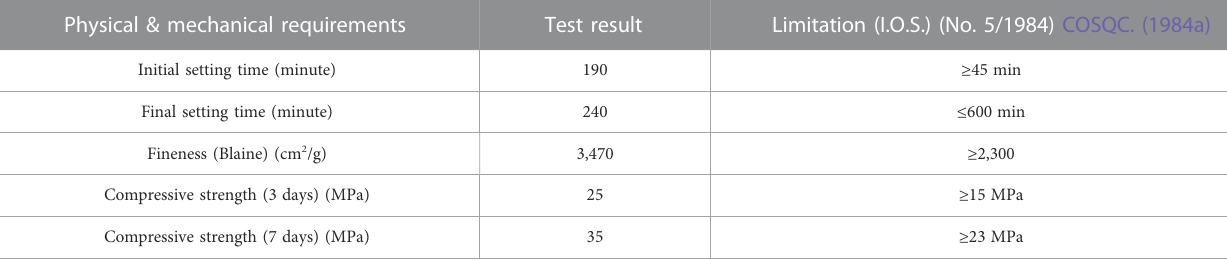
TABLE 2 The physical and mechanical characteristics of OPC Qaidi et al. (2022a). Physical & mechanical requirements